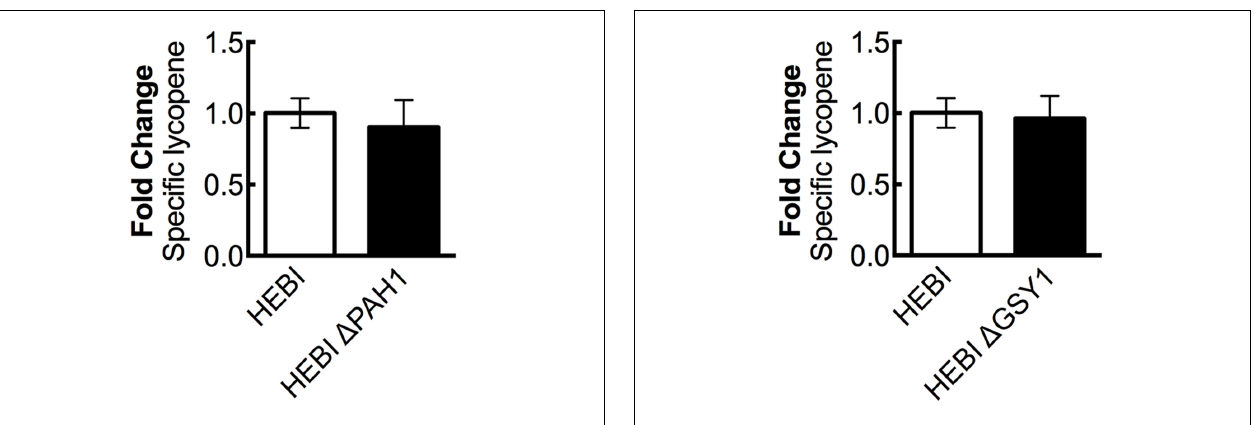
under the conditions used in this study, disruption of GSY1 did not lead to an increase in lycopene production.